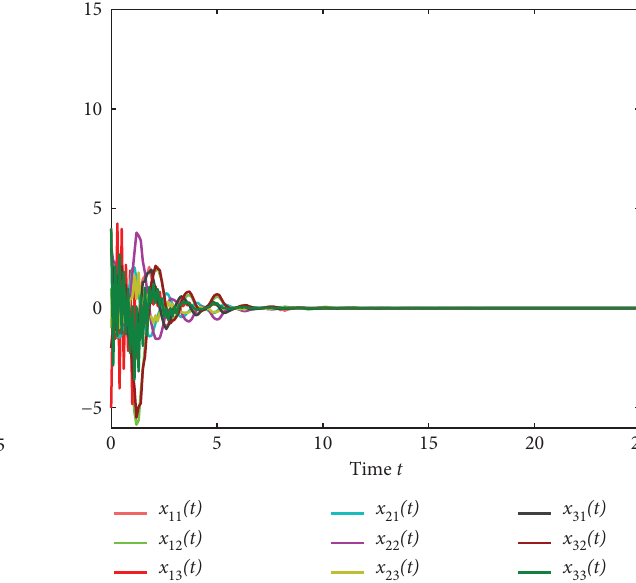
Figure 7: Trajectories of error system (37) with control inputs.